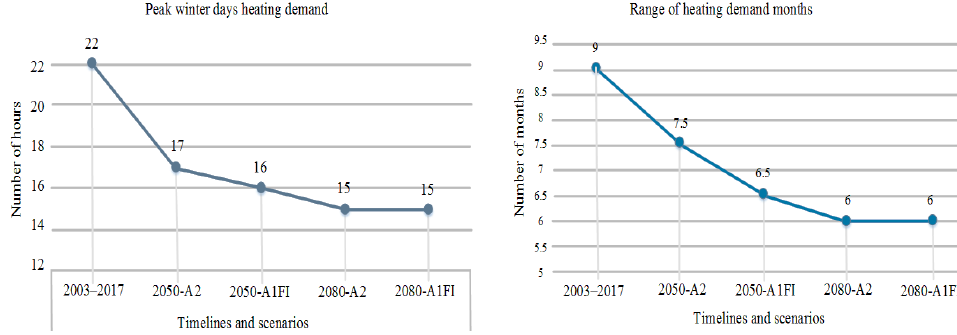
Fig. 9. Heating Period Specific